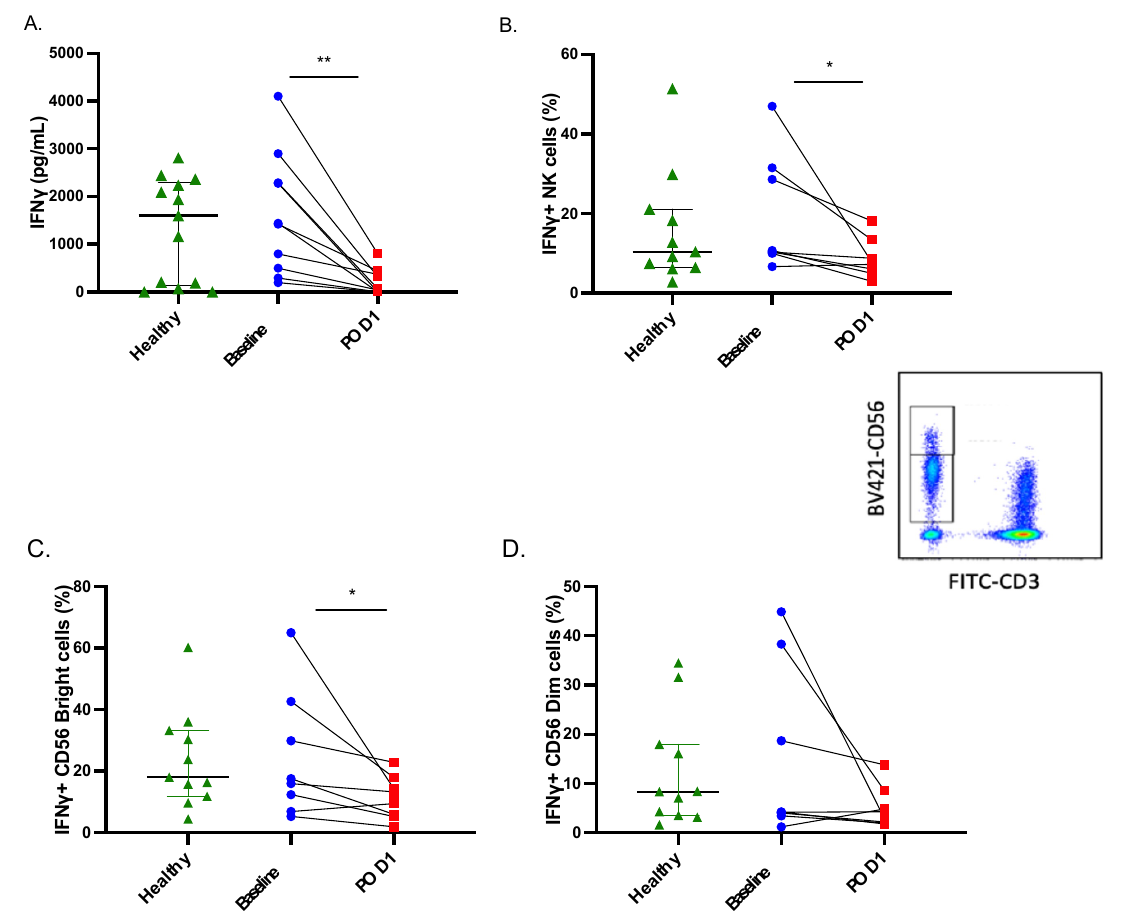
Figure 1. IFN γ secretion is significantly suppressed in postoperative NK cells. Whole blood was collected from healthy donors (green, median ± IQR shown) or patients undergoing cancer surgery at baseline (blue) and POD1 (red). Matched baseline and POD1 samples are indicated. ( A ) Whole blood was incubated for 24 h with NKVue TM to stimulate IFN γ secretion, which was quantified by ELISA. Intracellular IFN γ expression (IFN γ +) was determined in ( B ) total, ( C ) CD56 bright , and ( D ) CD56 dim NK cell populations following a 24 h stimulation of whole blood with recombinant inter ‐ leukin (rIL) ‐ 2 (400 U/mL; Tecin TM Teceleukin) and rIL ‐ 12 (20 ng/mL; R&D Systems cat#219 ‐ IL ‐ 005). * p ≤ 0.05, ** p ≤ 0.005.